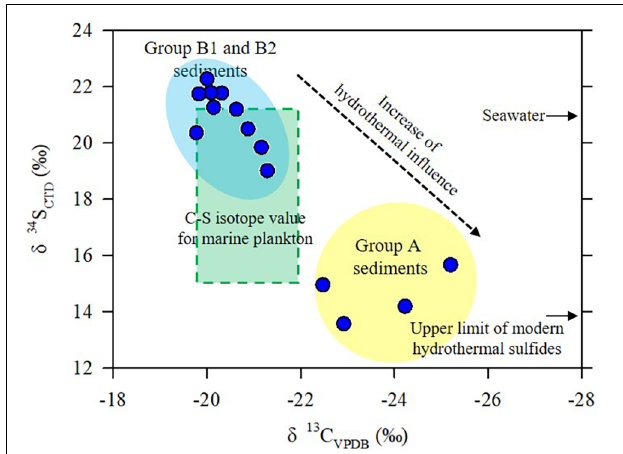
sulfur is similar to the dissolved sulfate ion, and fractionations are small ( + 0.5 to